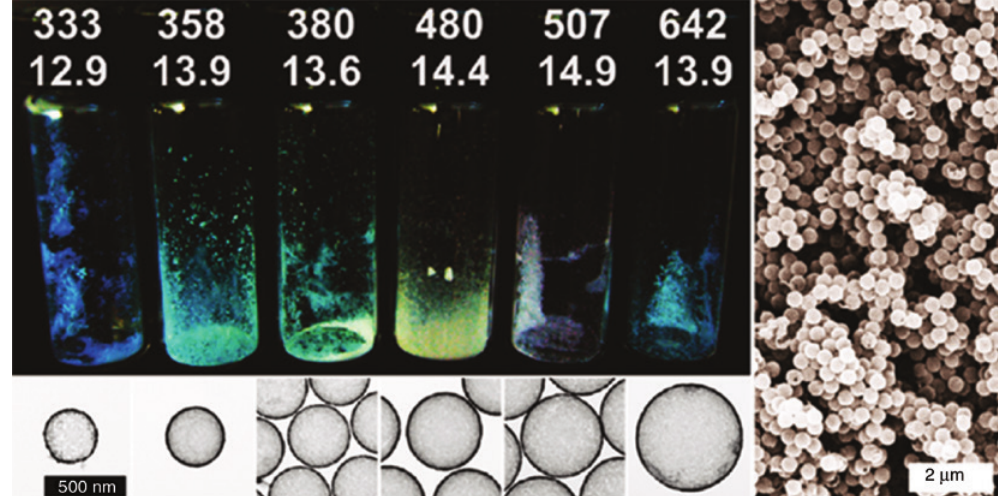
Figure 12: Amorphous powders of hollow silica spheres with various diameters displaying different colors, in which the numbers on top of the vials represent the diameter and shell thickness of hollow spheres in nanometers. The bottom panel shows the TEM images of the cor- responding hollow spheres. The right panel gives an SEM image of the 380-nm amorphous powder. Adapted with permission from ref. [51], COPYRIGHT 2011 American Chemical